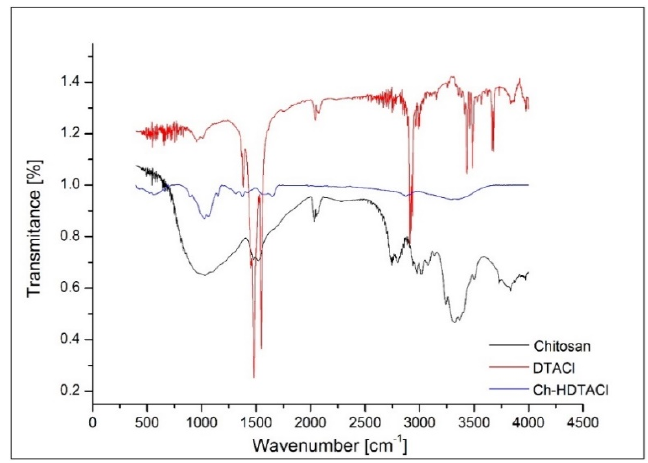
Figure 3. FTIR spectra.